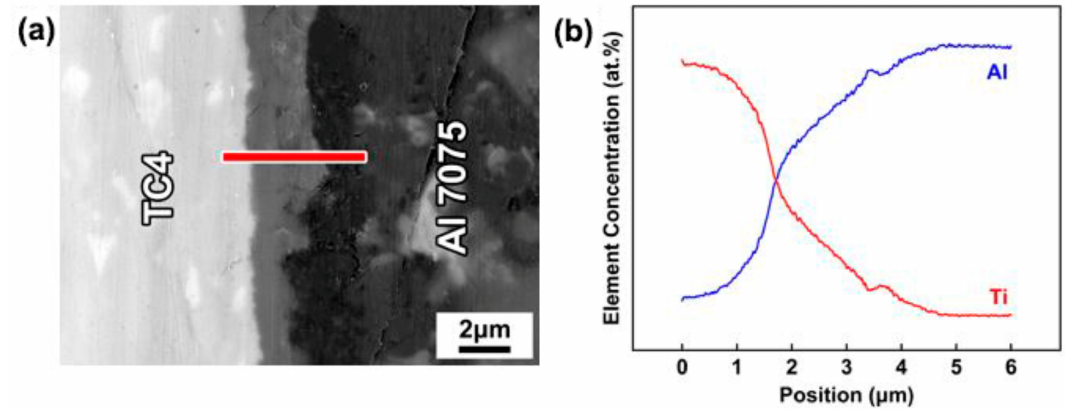
Figure 6. (a) Interfacial microstructure of brazed joint, (b) the EDS line scanning distribution of Ti and Al